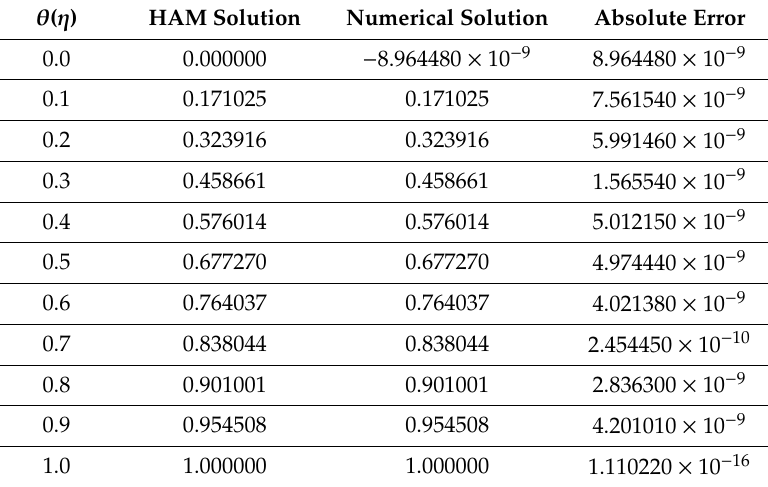
Table 5. Comparisons of the HAM and numerical